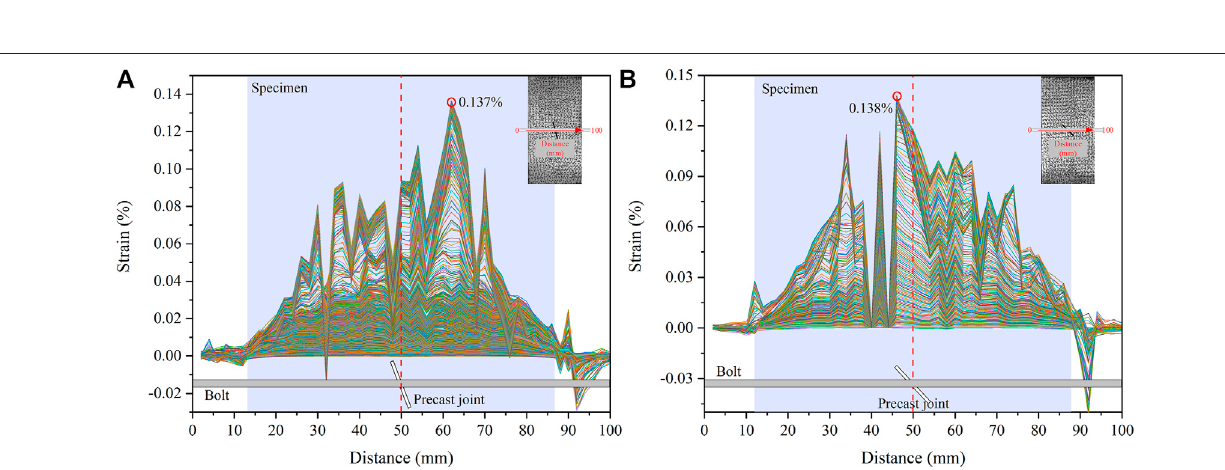
Frontiers in Earth Science |